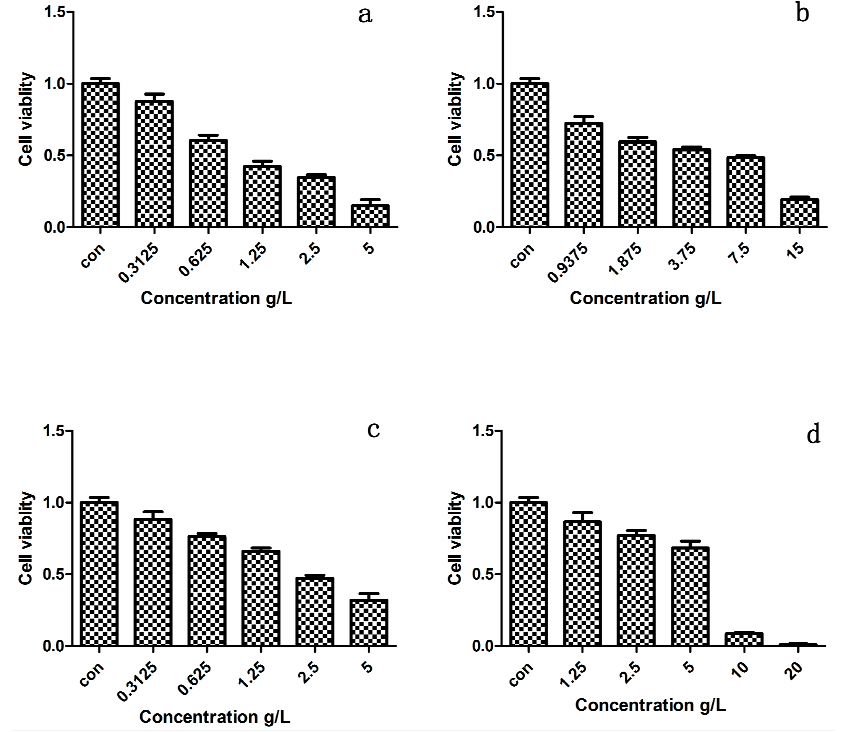
Figure 7. Cell viability of normal cells (LO2) treated with SY ( a ); SY-OMCS ( b ); AR ( c ) and AR-OMCS ( d ). Table 3. IC50 values of edible colorants on human liver cell lines (LO2).